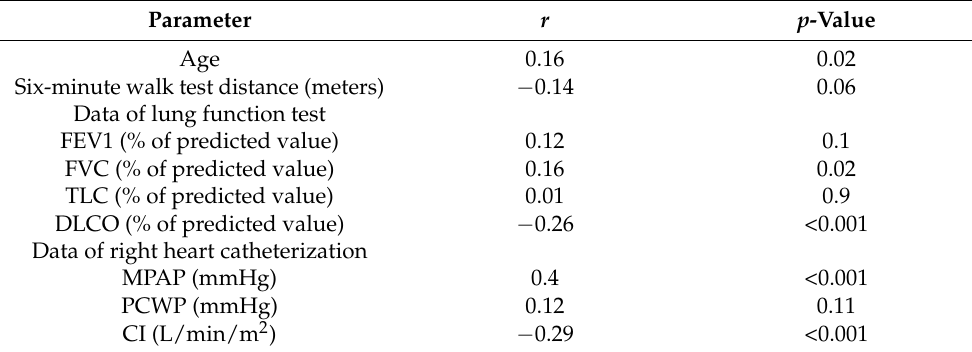
Table 3. Correlations between levels of NT-proBNP and other baseline parameters. Parameter r p -Value Six-minute walk test distance